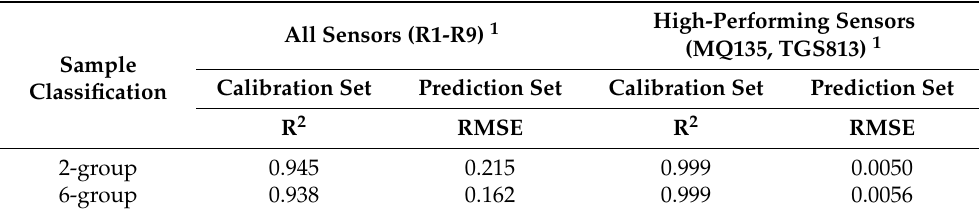
Table 4. Comparison of MAU-9 e-nose sensor sample-classification performance based on partial least square statistical